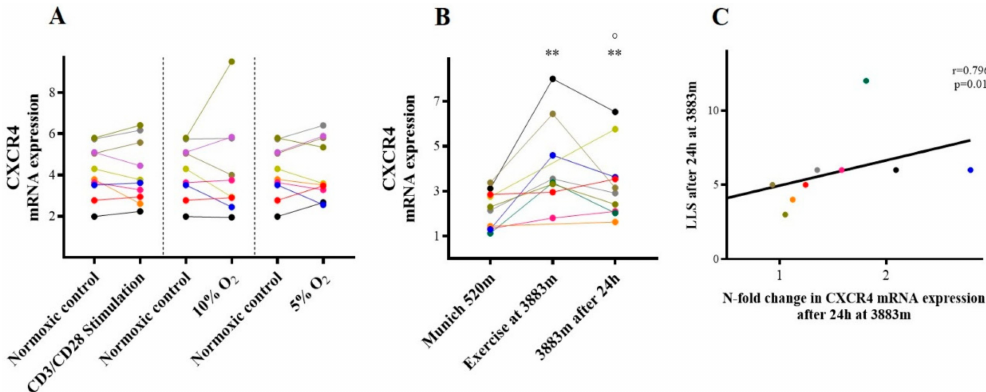
Figure 3. CXCR-4. CXCR-4 mRNA expression ( A ) in vitro following inflammatory and hypoxic incubation, and ( B ) in vivo at di ff erent timepoints. ( C ) Association between LLS and CXCR4 mRNA expression (n-fold change) at 3883 m after 24 h. ** p < 0.01 vs. baseline (Munich 520 m a.s.l. or normoxic control in vitro), ◦ p ≤ 0.05 vs. prior time point in vivo. CXCR4 = C-X-C chemokine receptor type